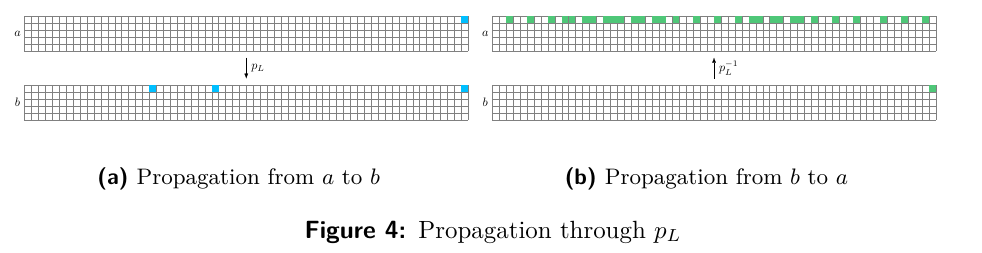
Figure 4: Propagation through p